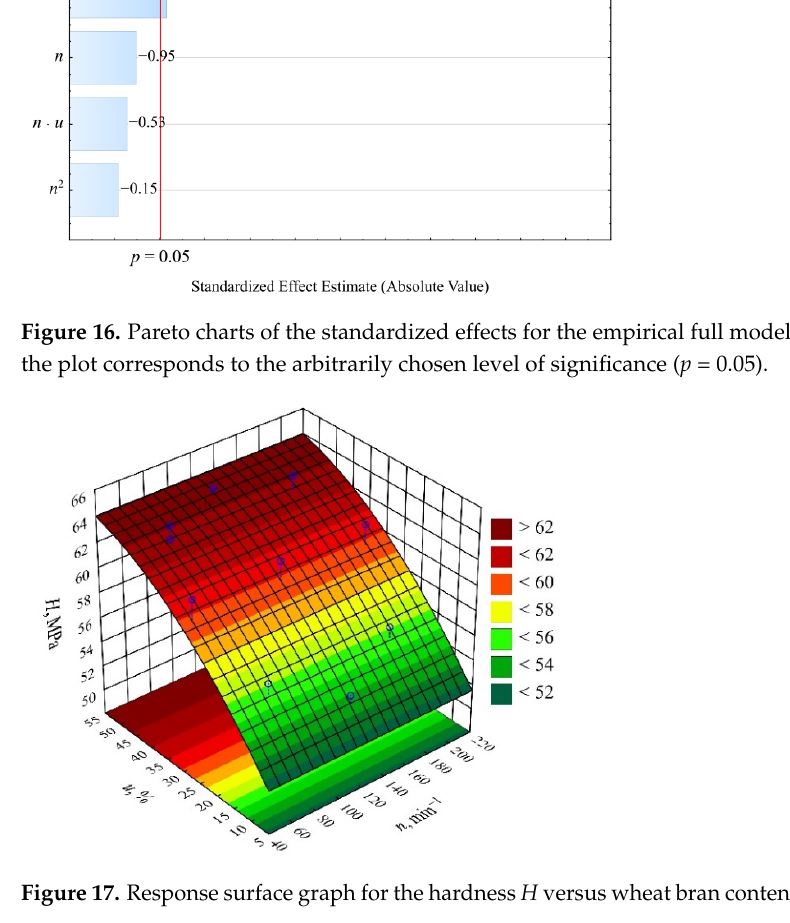
Figure 17. Response surface graph for the hardness H versus wheat bran content u and screw speed